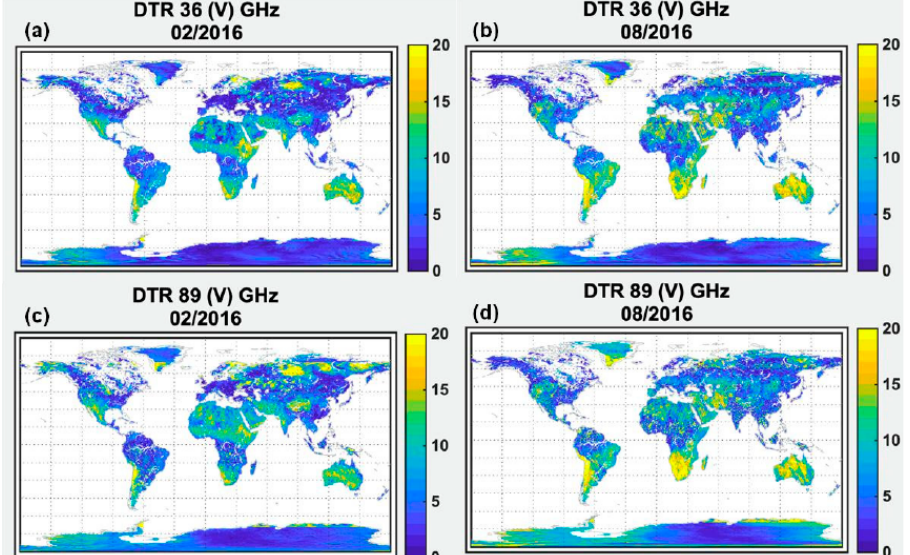
Figure 8. Spatial distributions of monthly diurnal brightness temperature range (DTR) (K) at ( a , b ) 37 GHz vertical polarization, and ( c , d ) 89 GHz vertical polarization for two contrasting seasons of ( a , c ) February 2016 and ( b , d ) August